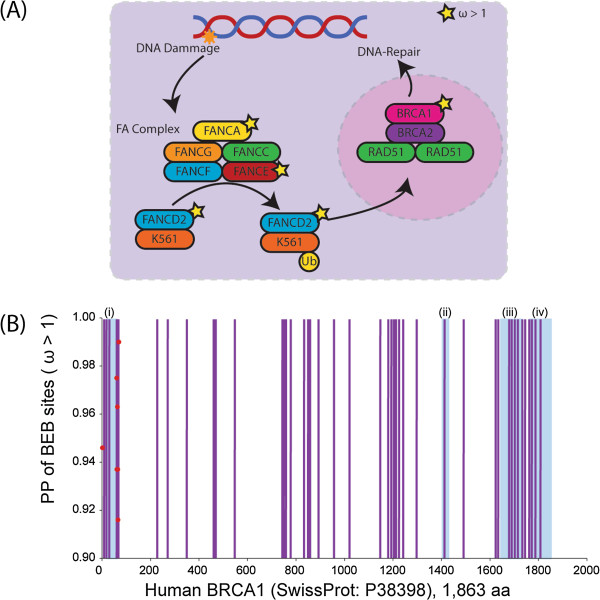
Lineage-specific positive selection in the naked mole rat BRCA1/FANC pathway. (A) The BRCA1/FANC pathway with genes under positive selection in naked mole rat denoted by a star. (B) Is a graphic of the BRCA1 protein from position 1 to 1853 on the x-axis. Positively selected sites (red dots) from naked mole rat were mapped to model sequence (from human). The posterior probability for each site is given on the y-axis. Functional information extracted from the human entry in swissport is colour coded as follows: blue regions represent (i) Zinc Finger, (ii) Interaction region with PALB2, (iii) BRCT1 domain, and (iv) BRCT2 domain while purple vertical lines are cancer causing natural variants.